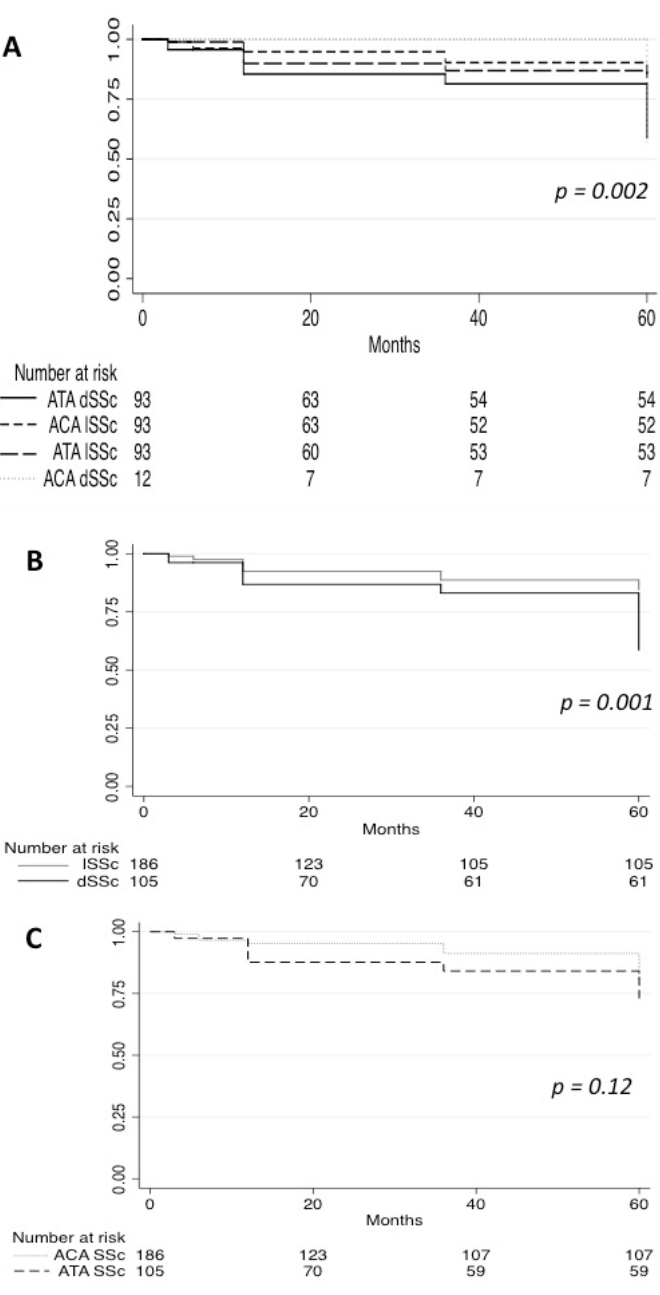
Figure 2. Five-year survival of SSc patients. ( Panel A ): Survival curves of ACA dSSc, ATA dSSc, ACA lSSc, and ATA lSSc. ( Panel B ): Survival curves of dSSc and lSSc patients. ( Panel C ): Survival curves of ACA and ATA SSc patients. ACA: anti-centromere antibodies; ATA: anti-topoisomerase 1 antibodies; dSSc: diffuse systemic sclerosis; lSSc: limited systemic sclerosis.